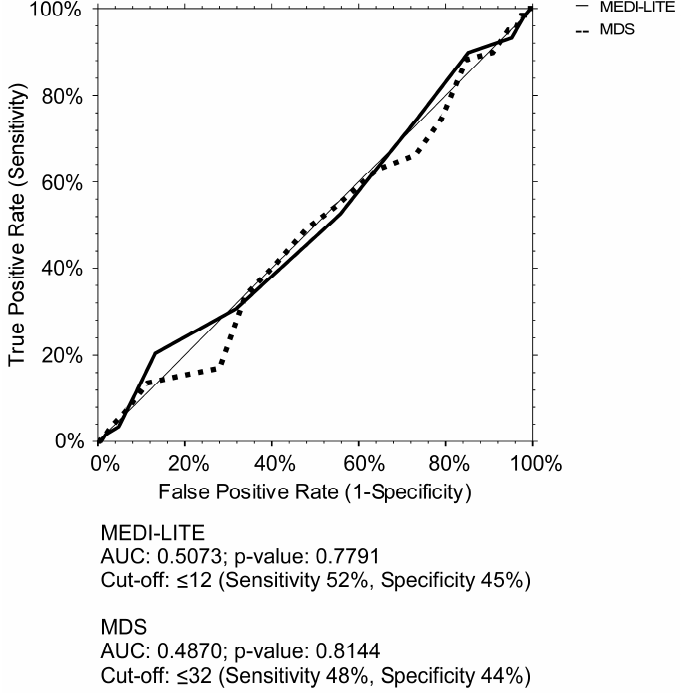
Figure 3. ROC curves of MDS and MEDI-LITE for increased waist circumference. ROC curves of MEDI-LITE score and MDS for increased waist circumference according to MetS IDF definition ( ≥ 94 cm in men and ≥ 80 in women).